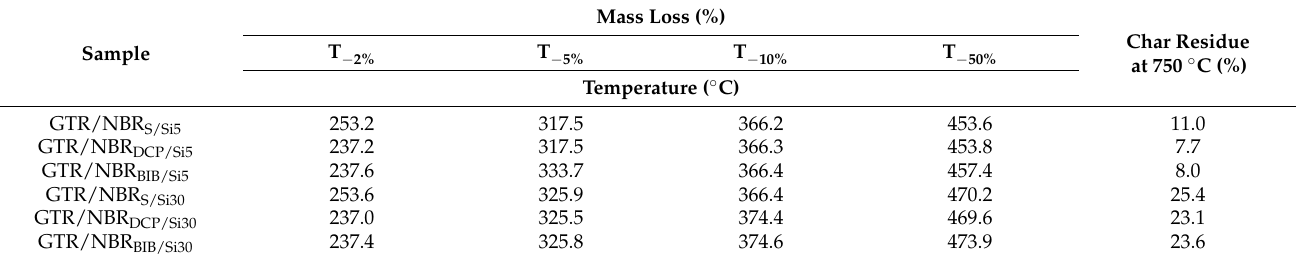
Table 5. Thermal decomposition characteristics of studied materials.